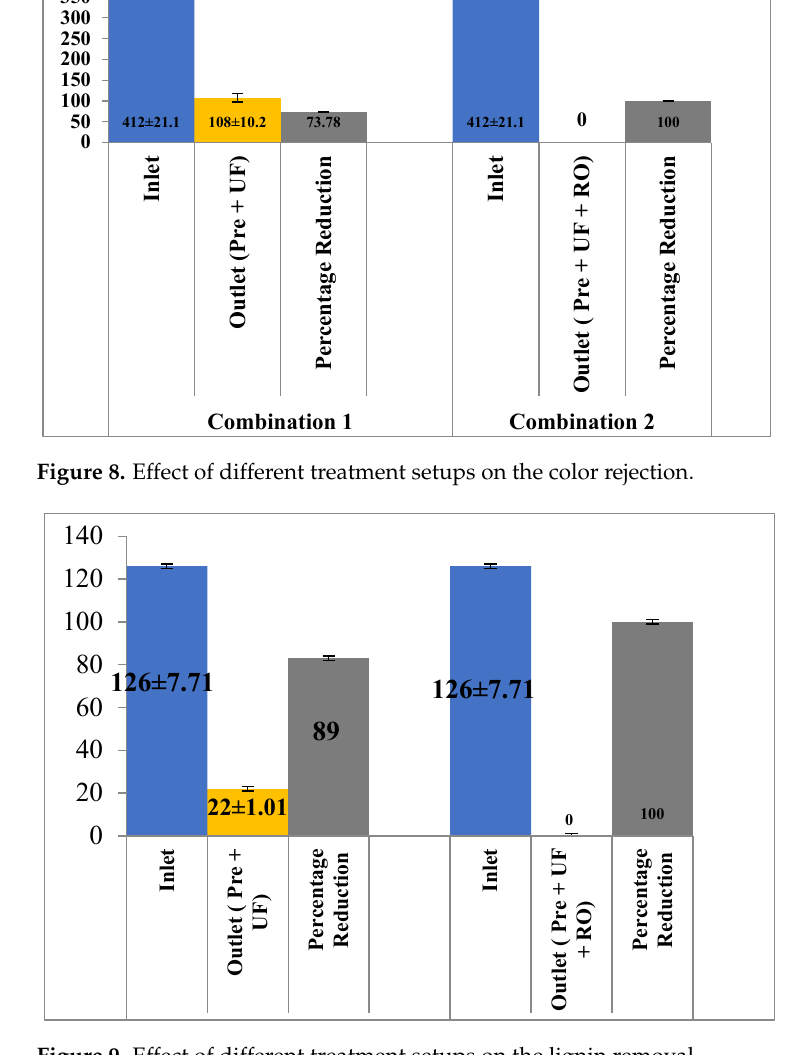
Figure 9. Effect of different treatment setups on the lignin removal .